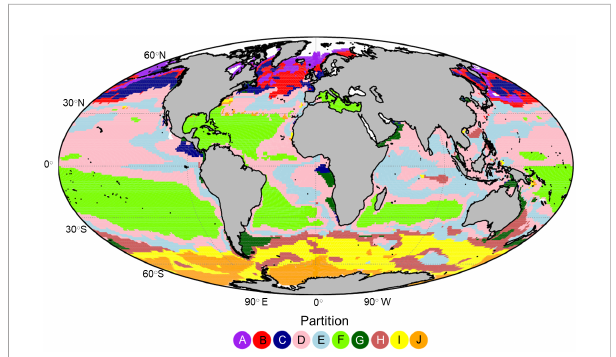
FIGURE 3 The global projection of the 10 global zooplankton partitions labelled (A-J) which were de fi ned using k -means clustering on the large zooplankton biomass measurements derived from the Darwin